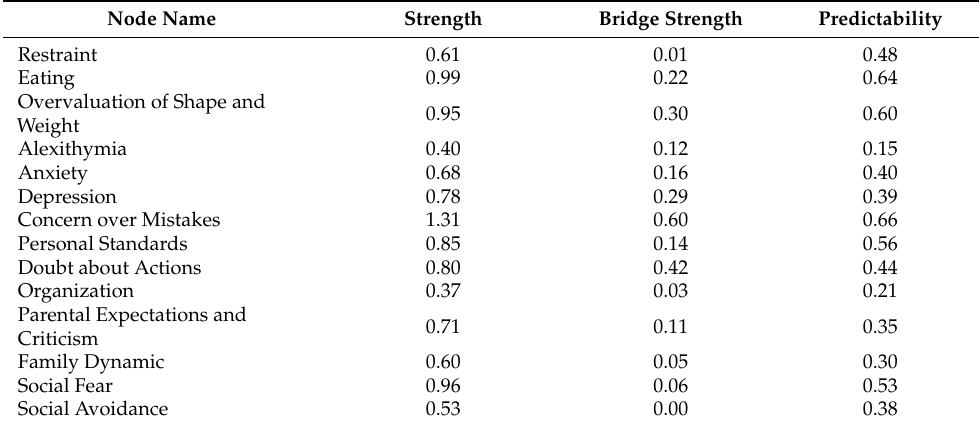
Table 2. Descriptive